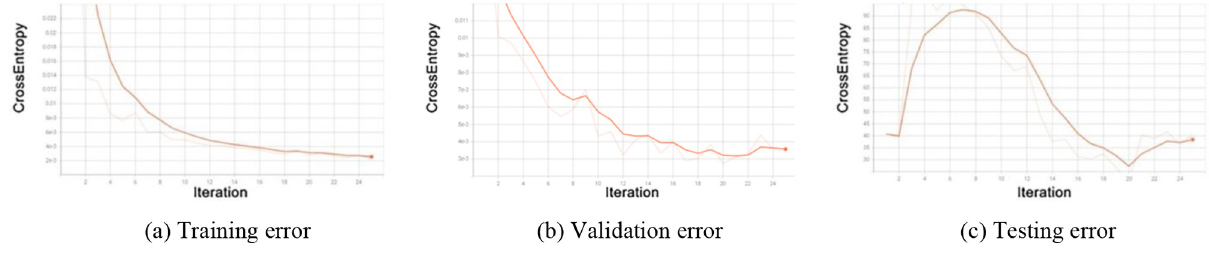
Fig 9. CrossEntropy convergence curve of the proposed method.